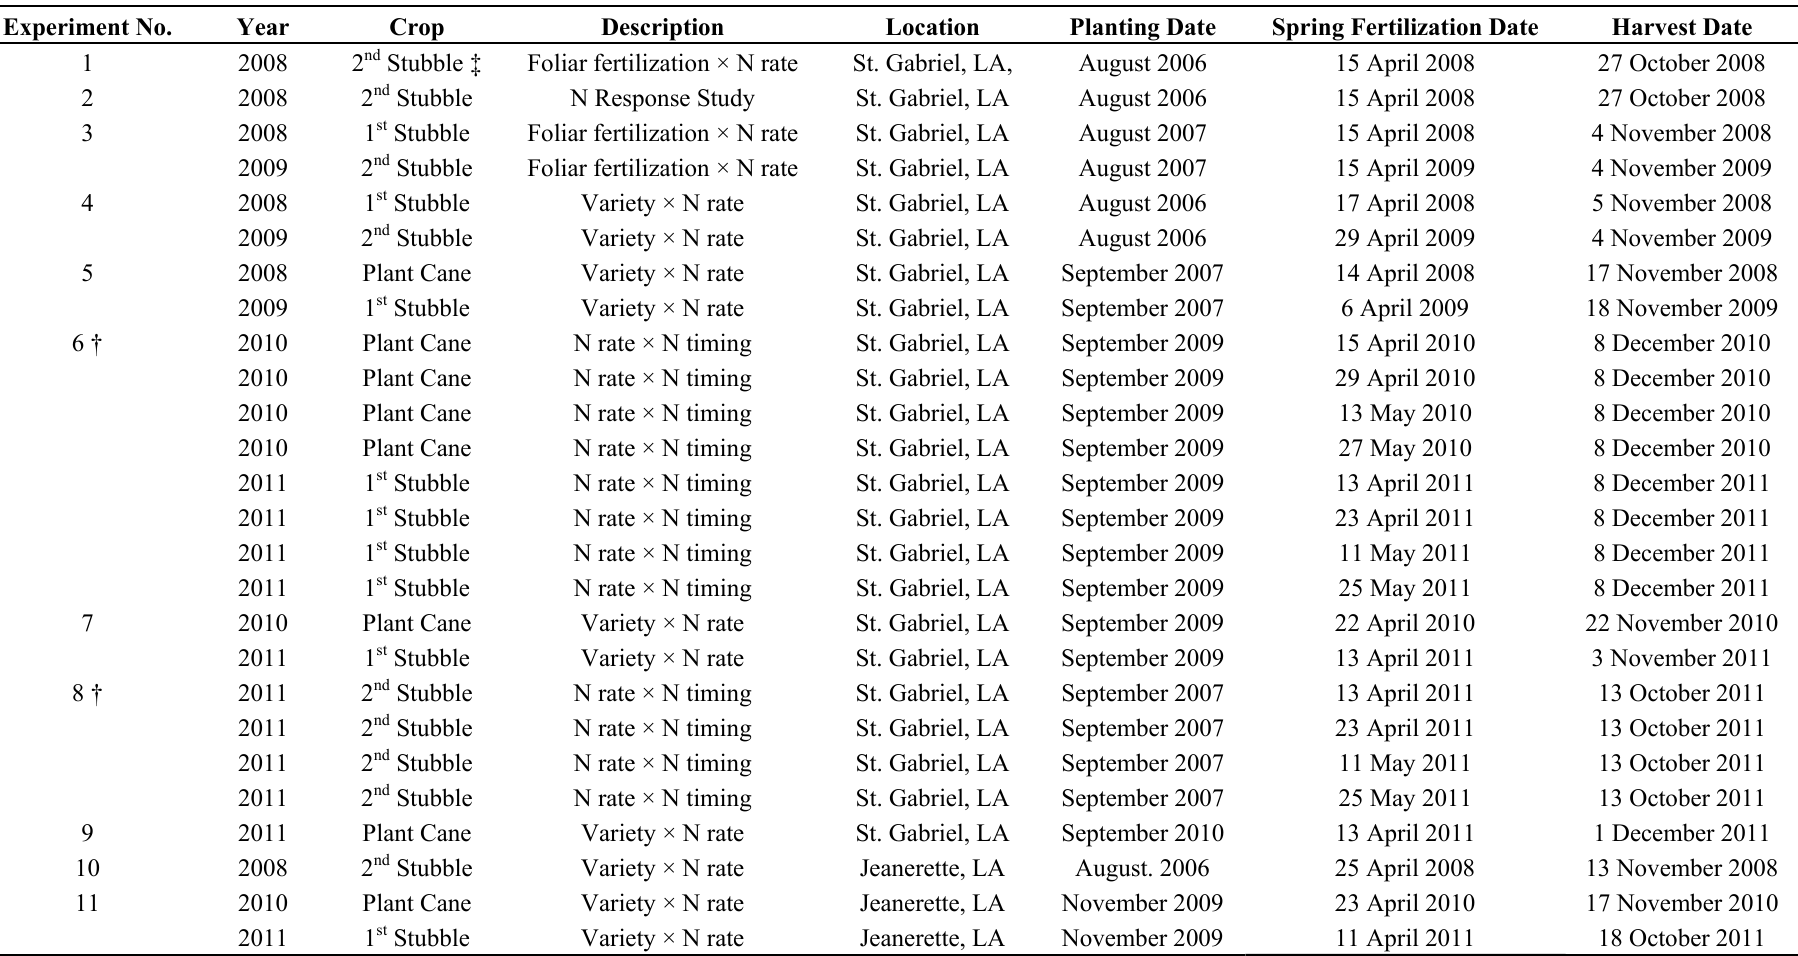
Table 3. Agronomic practices for all experiments established at St. Gabriel and Jeanerette, LA, USA from 2008 through 2011. Experiment